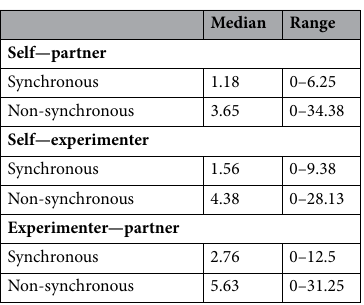
Table 5. Descriptive statistics for the Blurring scores form the Preference Overlap